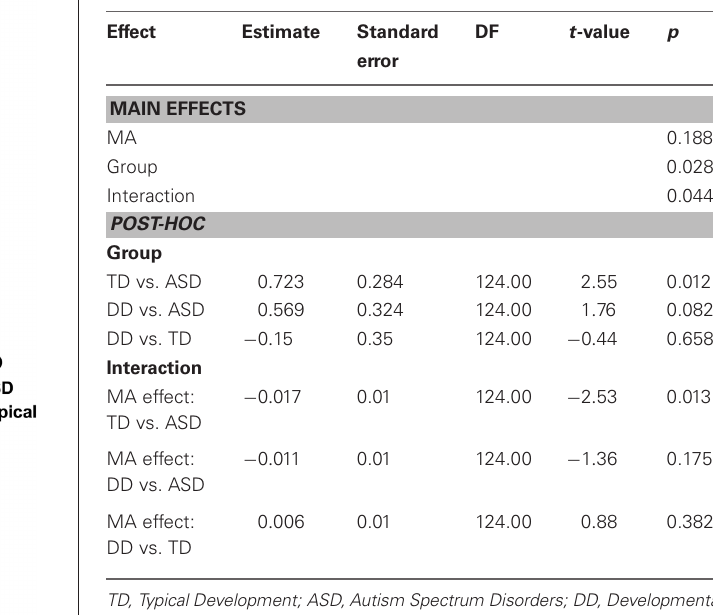
Table 6 | Time to peak grip force and mental age (MA).